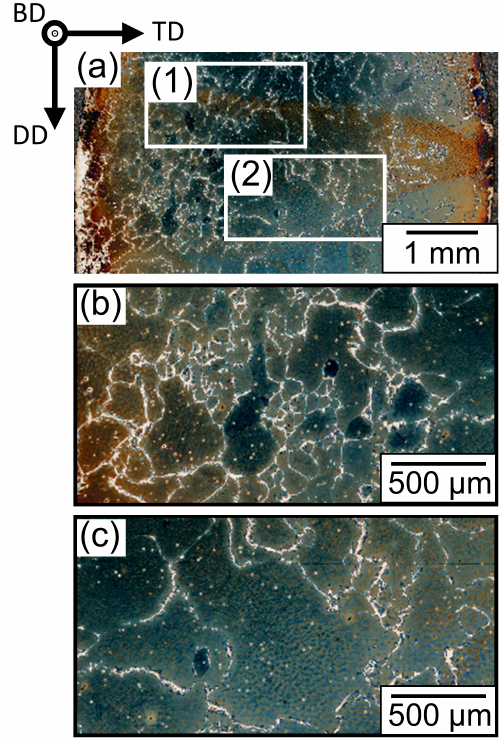
Figure 4. OM images obtained of the polished and etched DD-TD section; ( a ) overview of the cross-section; higher magnification detail of the area with small diameter grains ( 1 ) of approx. 65–180 µm is shown in ( b ) and of the larger diameter grains ( 2 ) up to 1.2 mm in ( c ); the sample coordinate system is defined by the building direction (BD), deposition direction (DD) and transverse direction (TD).